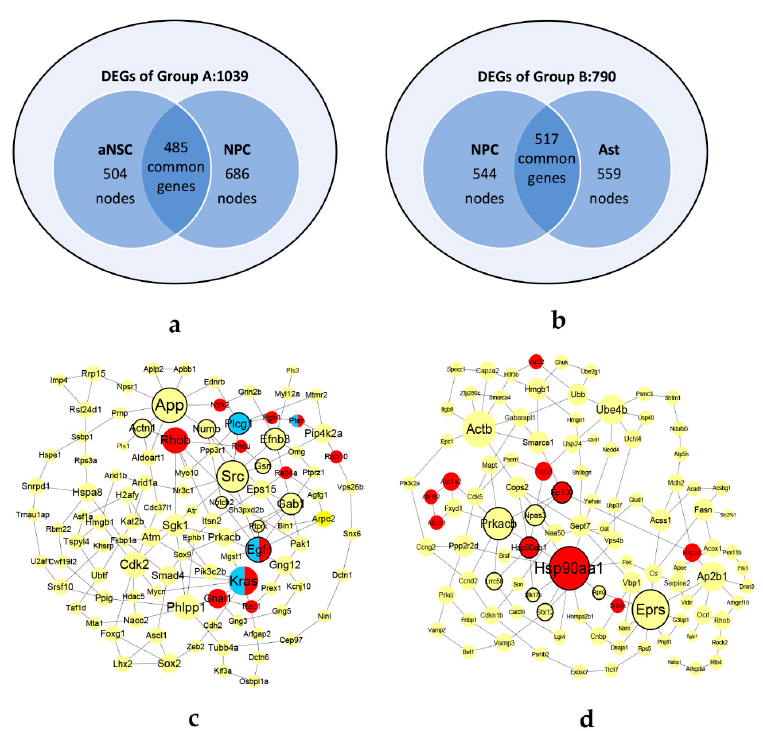
Figure 5. The datasets and KDSs of neural di ff erentiation. The pre-treatment datasets of Group A ( a ) and Group B ( b ). The KDSs of Group A ( c ) and Group B ( d ). In ( c ) and ( d ), the bolded border indicates the genes with high topological di ff erences. The genes marked in red are frequently occurring in GO terms. The genes marked in blue are enriched in Glioma pathway by KEGG enrichment analyses. The half blue half red nodes indicate that the genes occur frequently in GO terms and are enriched in Glioma pathway by KEGG enrichment